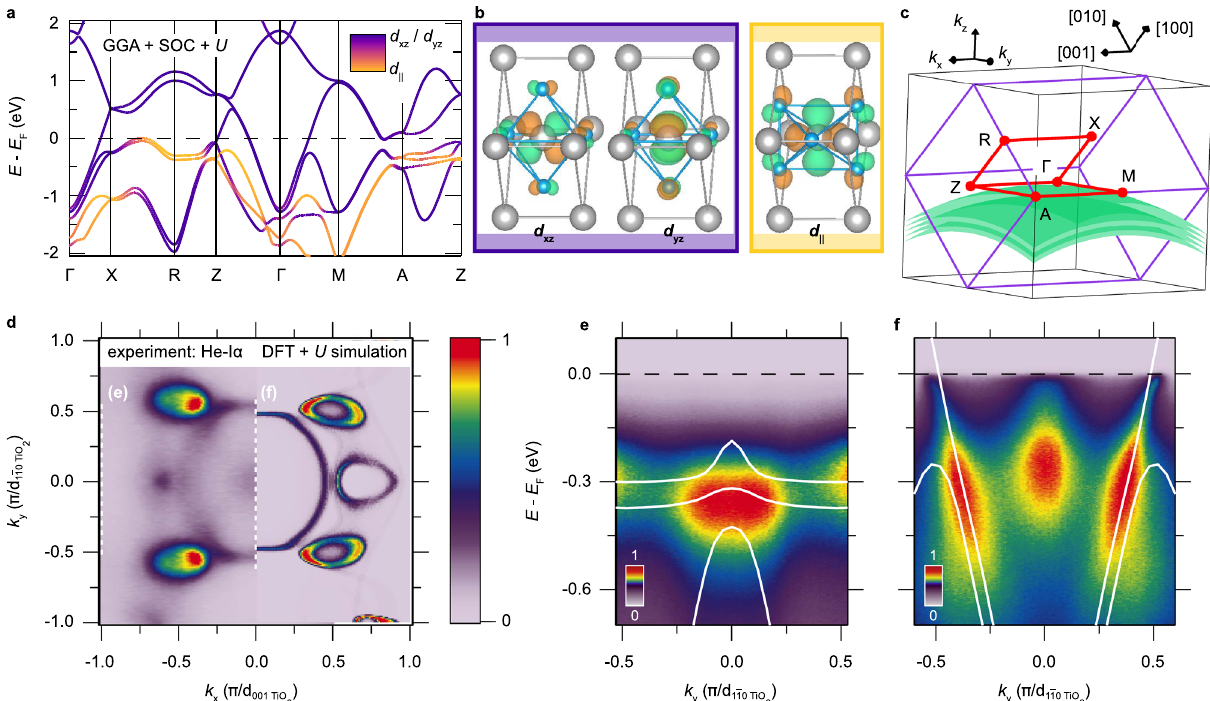
Fig. 3 Electronic structure of RuO 2 . a Non-magnetic band structure of RuO 2 (110) according to DFT, calculated within the generalized gradient approximation (GGA) including spin – orbit coupling (SOC) and a static + U = 2 eV correction on the Ru sites. The color scale indicates the magnitudes of projections of the Kohn-Sham eigenstates at each k onto Ru-centered Wannier functions with d ∣∣ and ( d xz , d yz ) orbital characters, which are constructed from the manifold of self-consistent eigenstates spanning E F and are plotted in drawings of the crystal structure in ( b ). Ru (O) atoms are colored gray (blue), as in Fig. 1a, b. Green and orange surfaces in ( b ) represent isosurfaces of the Wannier functions that have equal absolute magnitudes, but opposite (i.e., positive and negative) signs, respectively. c Brillouin zone schematic de fi ning the coordinate system utilized for describing ARPES measurements of the electronic structure on (110)-oriented surfaces: k x ∣∣ [001] rutile , k y jj ½ 110 (cid:2) rutile , and k z ∣∣ [110] rutile . The Brillouin zone of the parent tetragonal rutile structure is outlined in purple, the high-symmetry contour for the spaghetti plot from ( a ) is colored red, and the region probed on (110)-oriented surfaces with He-I α photons (21.2 eV) is shaded green (Supplementary Note 6 and Supplementary Fig. 13). d Slice through the Fermi surface experimentally measured for a 7 nm thick RuO 2 (110) fi lm (left), compared to the Fermi surface from DFT + U simulations (right) projected onto the region of the Brillouin zone colored green in ( c ). E ( k ) spectra acquired along the one-dimensional cuts indicated by dashed white lines in ( d ) show: e fl at bands with d ∣∣ orbital character and f more dispersive bands with ( d xz , d yz ) character, both consistent with DFT + U expectations (solid white lines). The intensities of the experimental data shown in ( d – f ) and of the DFT simulations shown in ( d ) are plotted in arbitrary units where we de fi ne 0 (1) to be the minimum (maximum) value, respectively, of the given data set. Only relative changes in intensity within a given panel (as visualized by the false color scales) are ARPES data over the full measured region of k -space for both samples gives the average energy distribution curves plotted in Fig. 4c, which show that spectral weight near E F is enhanced as the d ∣∣ states move towards E F , in qualitative agreement with the trend predicted by DFT. Our results indicate that the primary electronic effect of the epitaxial strains in RuO 2 (110) is to alter the relative occupancies of the d ∣∣ and ( d xz , d yz ) orbitals as com- pared with bulk, and to push a large number of states with d ∣∣ character closer to E F , which enhances N ( E F ) and likely T c .